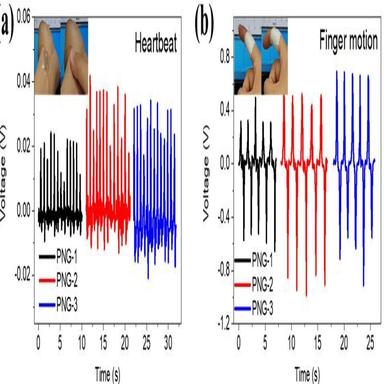
The generated output voltage performance from the PNGs used for heartbeat monitoring system attached to wrist (a) and human motion monitoring system attached to index finger (b).